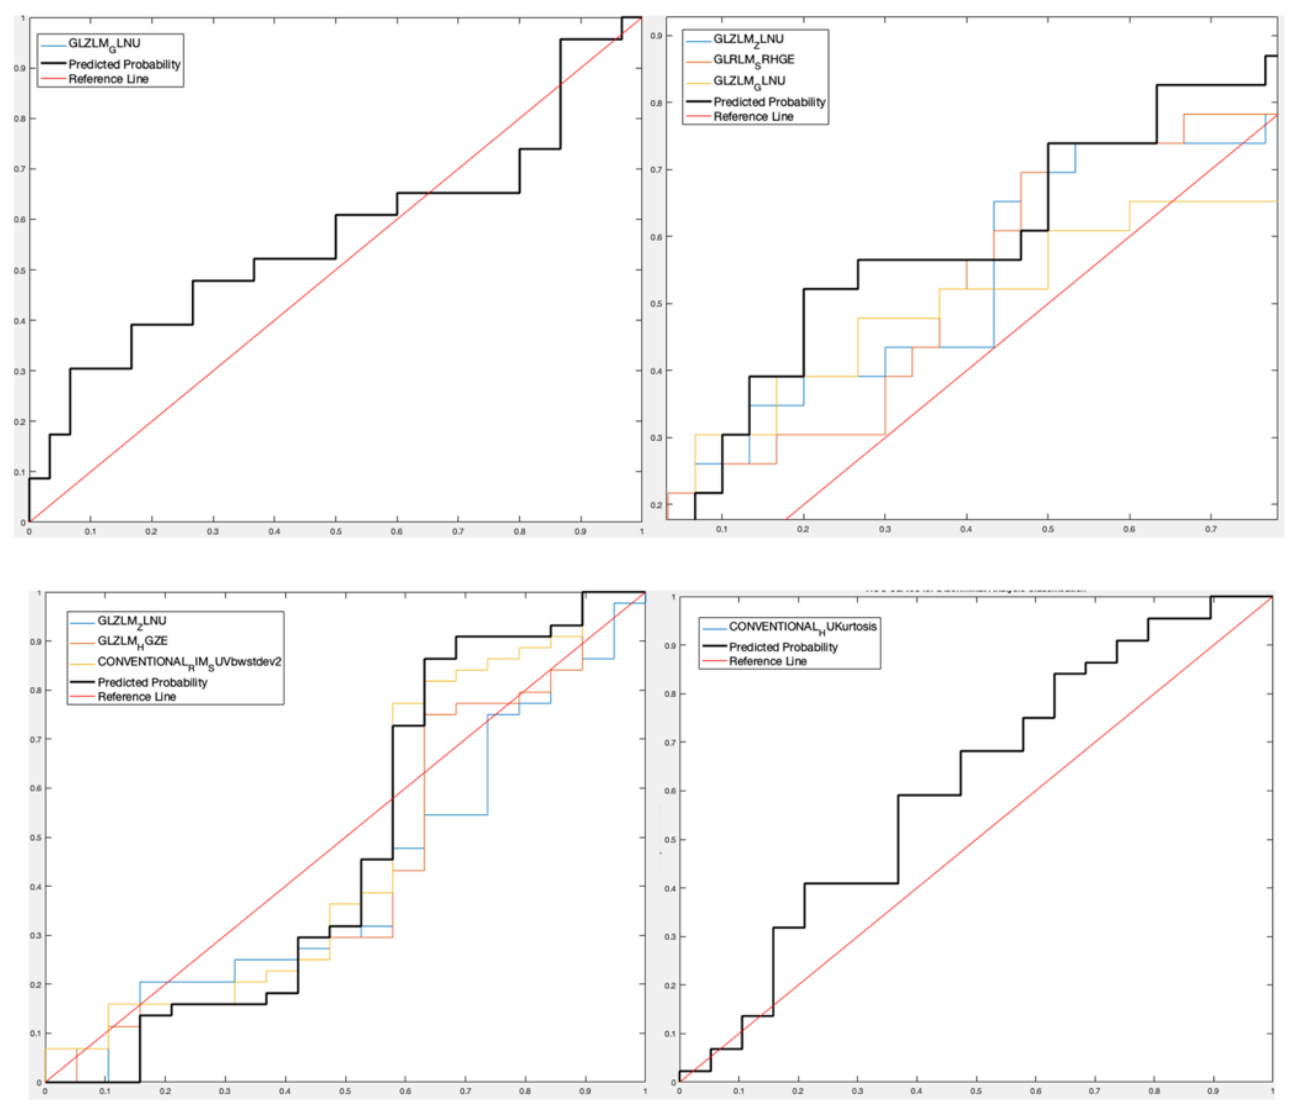
Figure 2. ROCs for the four radiomics models obtained per lesion (first row) and per-patient analyses (second row) for PET-only (first column) and PET/CT images (second column), with an AUROC of 56.52%, 65.22%, 47.97%, and 61%, respectively. Table 2. Performances of radiomics features in prediction of progression of disease in all lesions, per-patient, and per-lesion